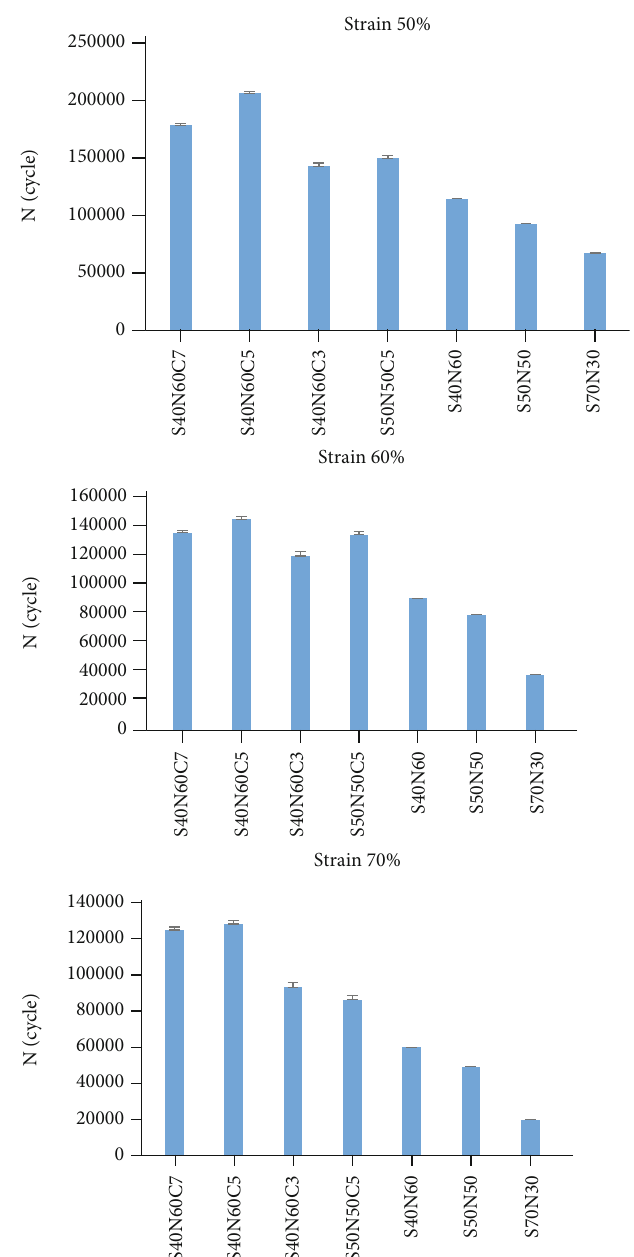
Figure 12: Investigation of fatigue test data scatter in terms of di ff erent rubber compositions in di ff erent strain